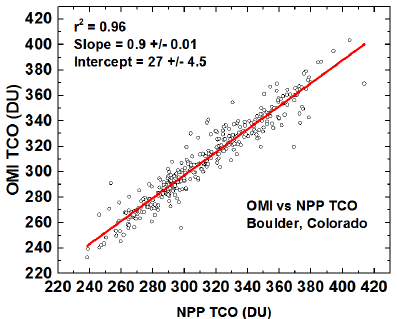
Figure 9. Scatterplot of NPP OMPS vs. AURA OMI TCO.